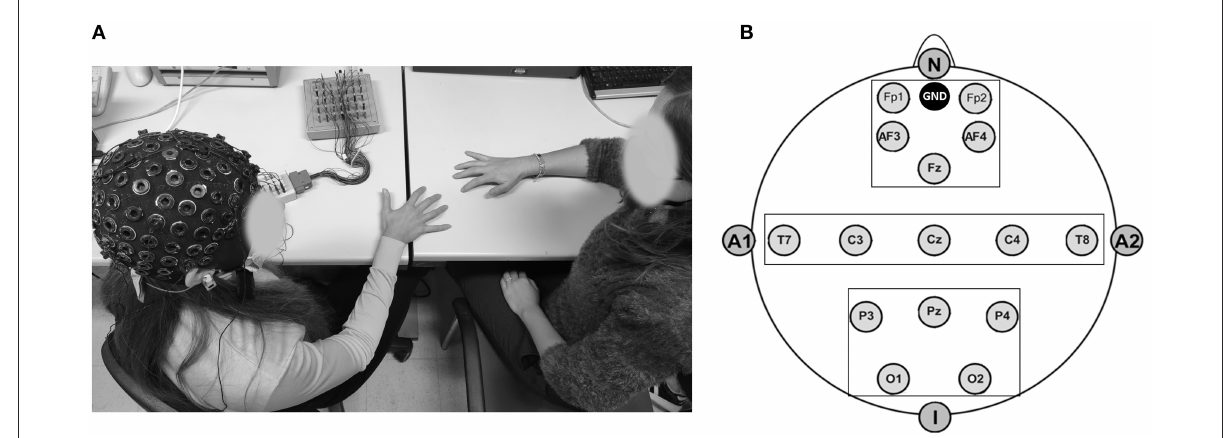
FIGURE2 (A,B) EEG setting for data collection and layout adopted for the study. (A) Experimental setting displaying the participant wearing the EEG cap and performing the motor synchronization task with the experimenter. (B) Montage design included 15-electrodes positioning according to the 10–20 International System (Jasper, 1958) and divided in three main regions of interests: antero-frontal, temporo-central, and